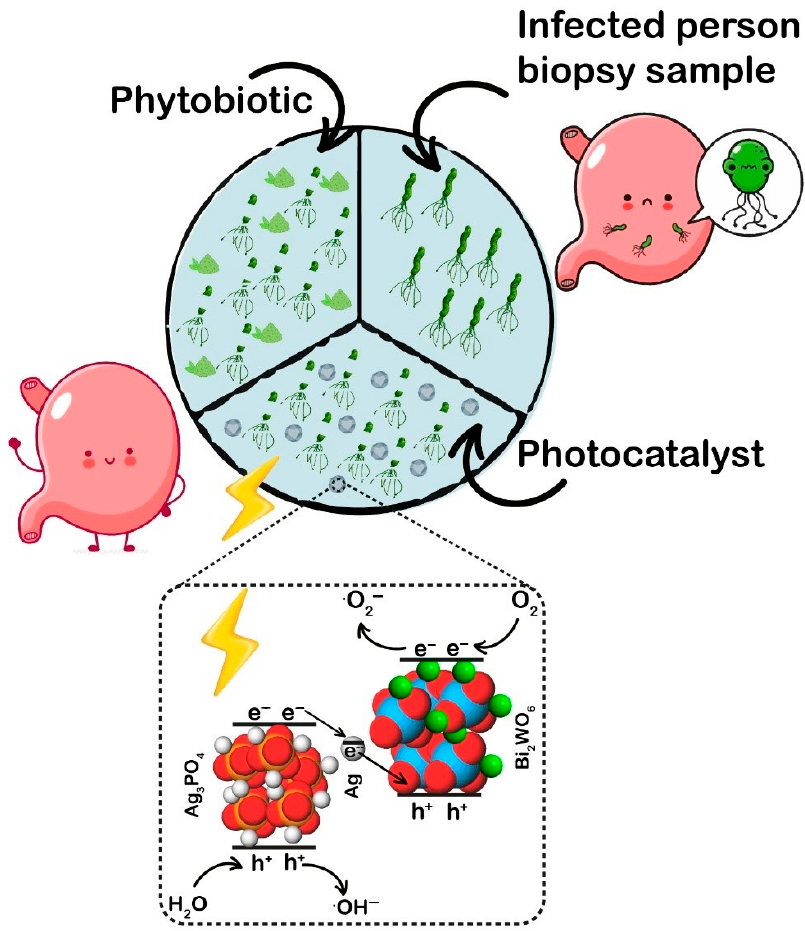
Figure 1. Schematic illustration of photocatalytic and phytobiotics disinfection by Bi 2 WO 6 /Ag 3 PO 4 /Ag and Oak fruit extract.